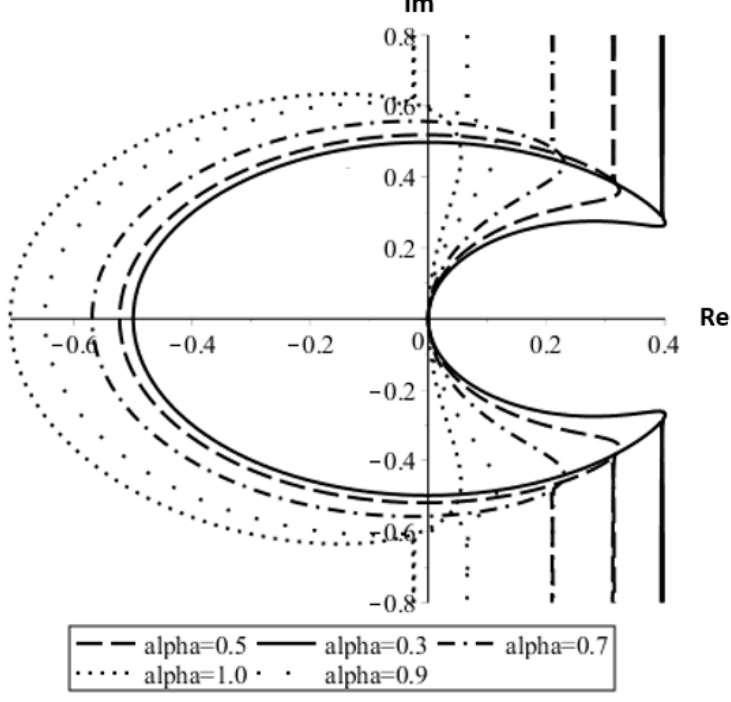
Figure 2. Stability region of FEAM3 for different values of α